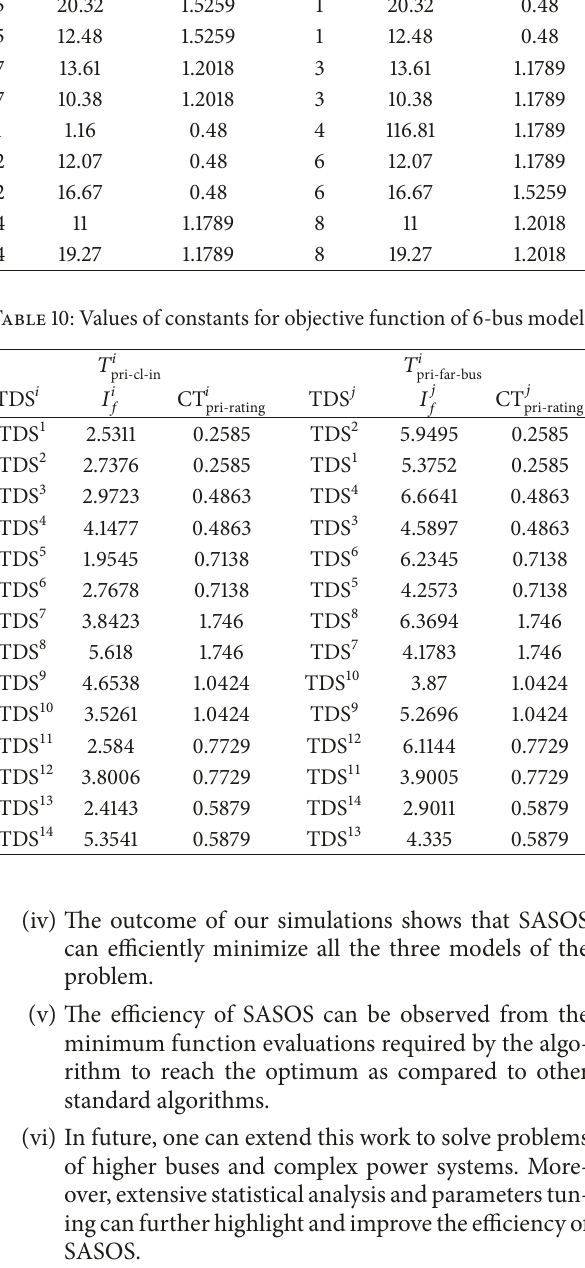
Table 11: Values of constants for 𝑇